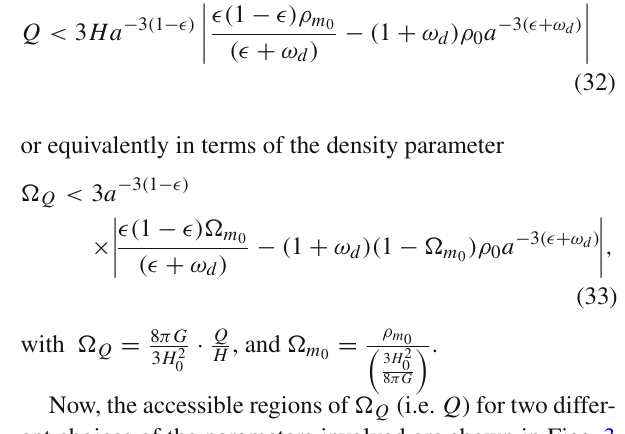
= 0 . 30 and (cid:12) = 0 . 0